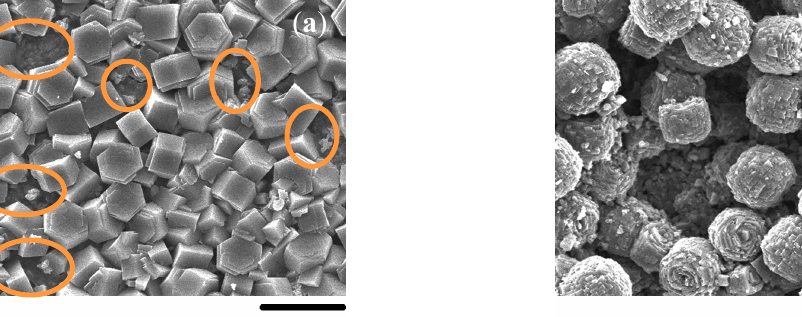
Figure 11. SEM images of SAPO-5 layers synthesized on unmodified α -Al 2 O 3 substrates using AIP ( a ) and pseudo-boehmite ( b ) as the Al source. Scale bars correspond to 20 μ m.